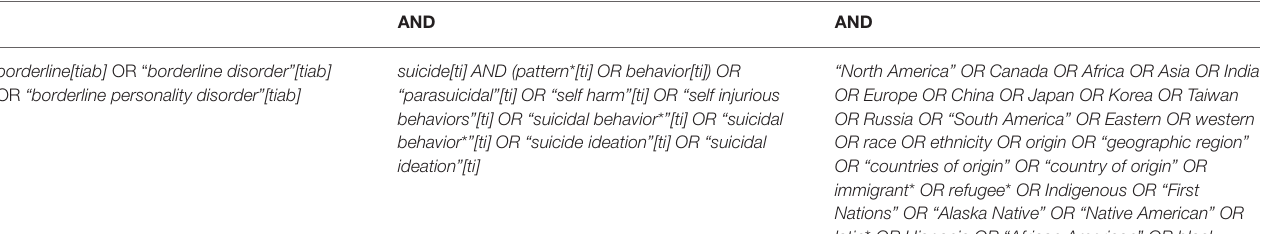
TABLE 1 | Literature search keywords.